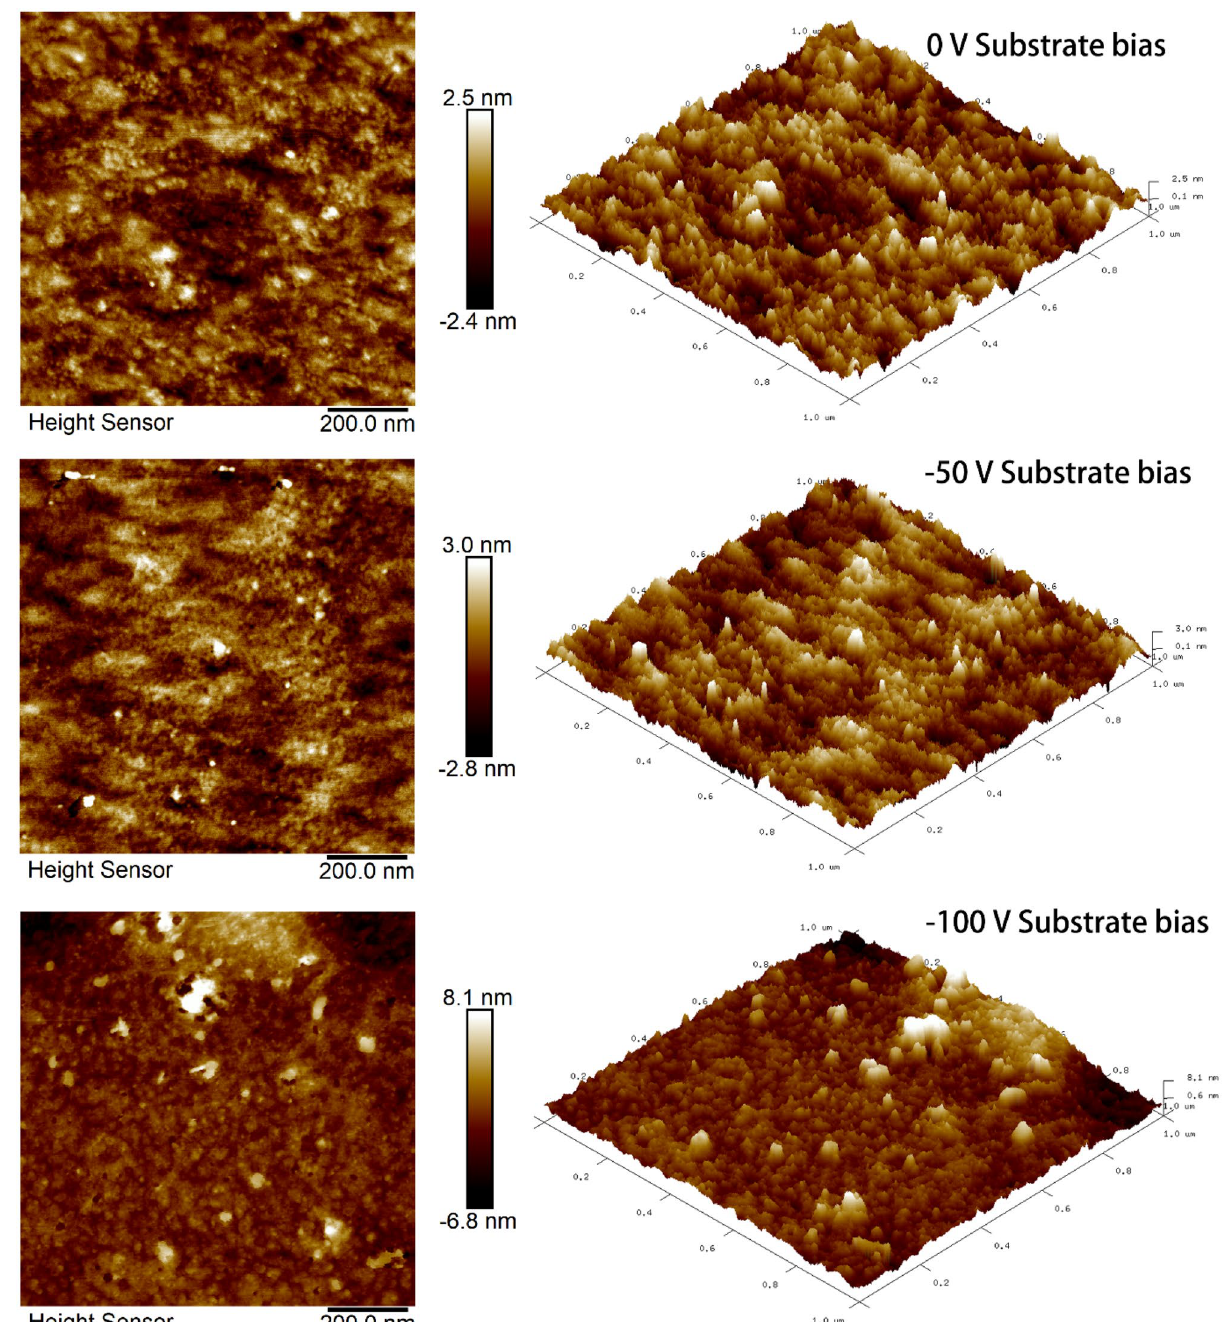
Figure 10. AFM analysis of the HEA thin films deposited at 0 V, −50 V, and −100 V substrate